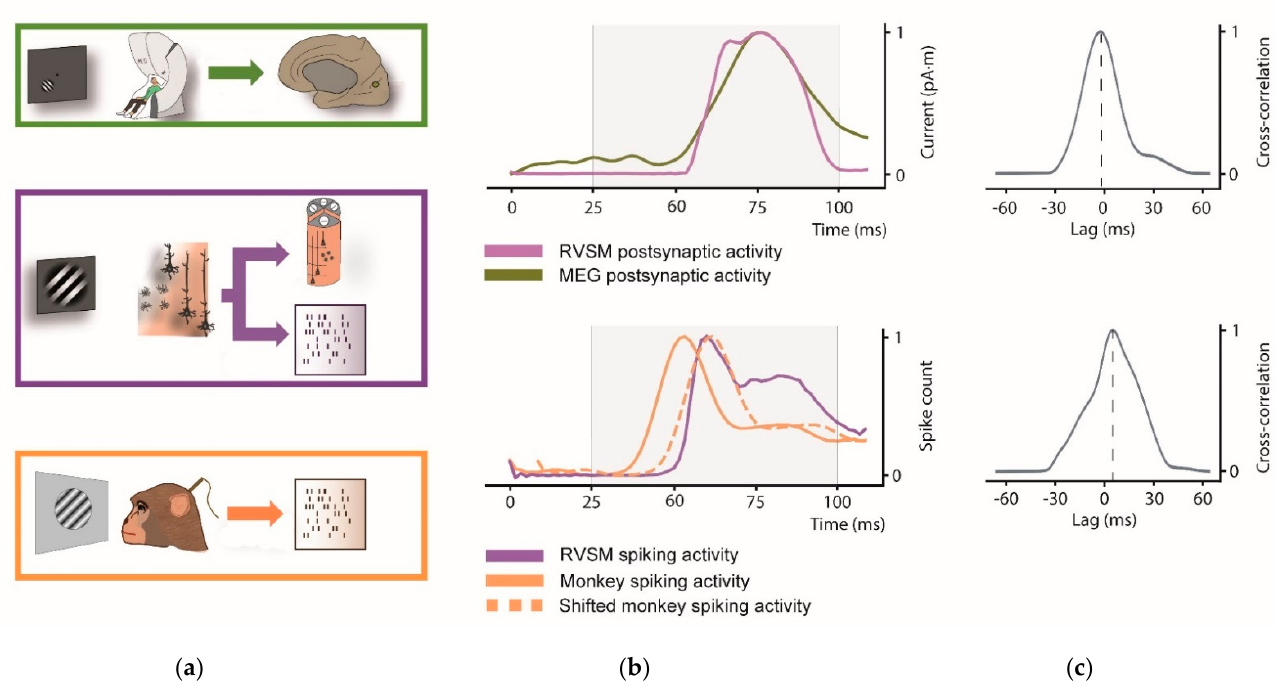
Figure 7. Response time series of the visual evoked potential obtained after the presentation of Gabor patch in human, RVSM model and monkey V1. ( a ) Scheme of the pipeline for real and simulated data. Activity arising from a left lower Gabor patch visual stimulation was recorded by MEG and then source reconstruction was computed to extract current activity of upper right V1 (green). The same Gabor patch was presented to the artificial retina, computing all pinwheel columns responses in order to obtain the current activity from apical dendrites of pyramidal neurons and spiking activity of all pinwheel neurons (purple). Rhesus spiking activity of visual evoked response recording to the same orientation and contrast Gabor patch viewing (orange); ( b ) Top: MEG signal averaged on the 30 subjects (green) and current dipole activity of the complete pinwheel of the RVSM responding to a 45° Gabor patch (purple). Bottom: spiking activity of RVSM (purple), monkey response (orange) and lag-corrected monkey response (dashes orange). Both plots were normalized by scaling between 0 and 1 to span the same range. Shifted activity for MEG recordings is not reports since it is considered near 0-lag ; ( c ) Cross-correlation of postsynaptic (top) and spiking (bottom) activity to estimate the lag between the real and model activity.